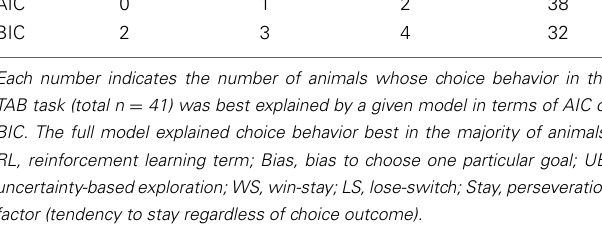
FIGURE 5 | Correlations between trial duration and model parameters. WS ( S reward ), win-stay; LS ( S 0 ), lose-switch; ε , coefficient for uncertainty-based exploration; α pos , learning rate for positive outcome; α neg ,